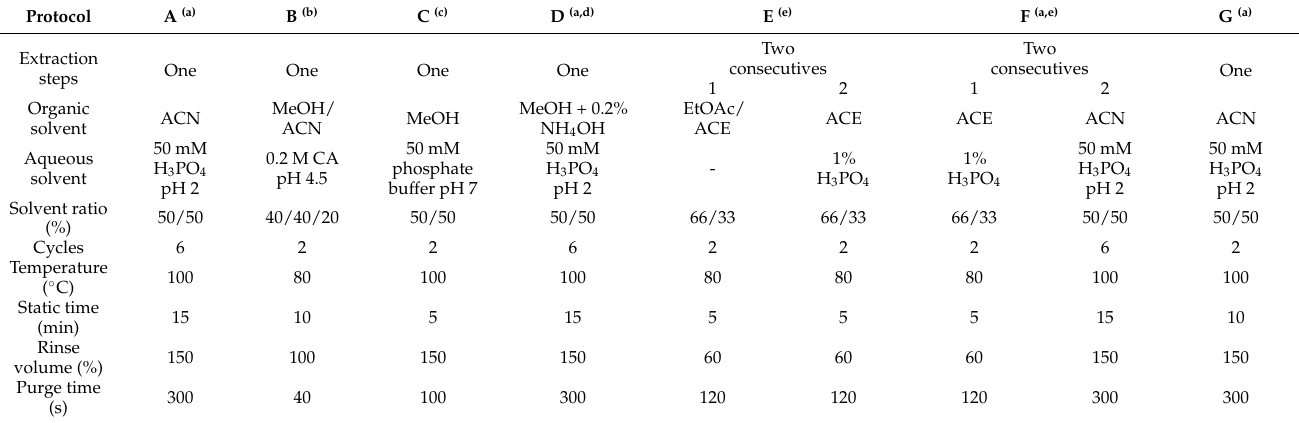
Table 1. The characteristics and parameters of the PLE protocols used in the